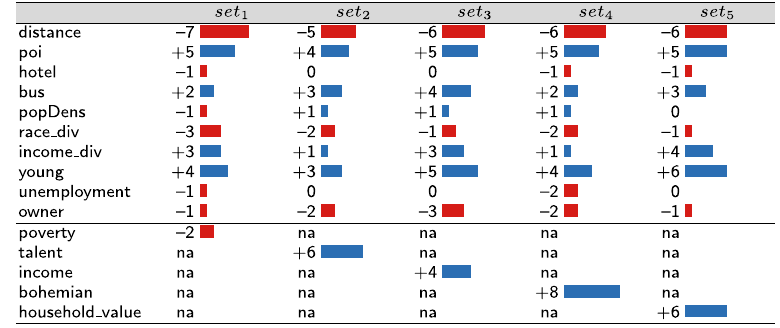
Table 4 Aggregated results for five different sets of